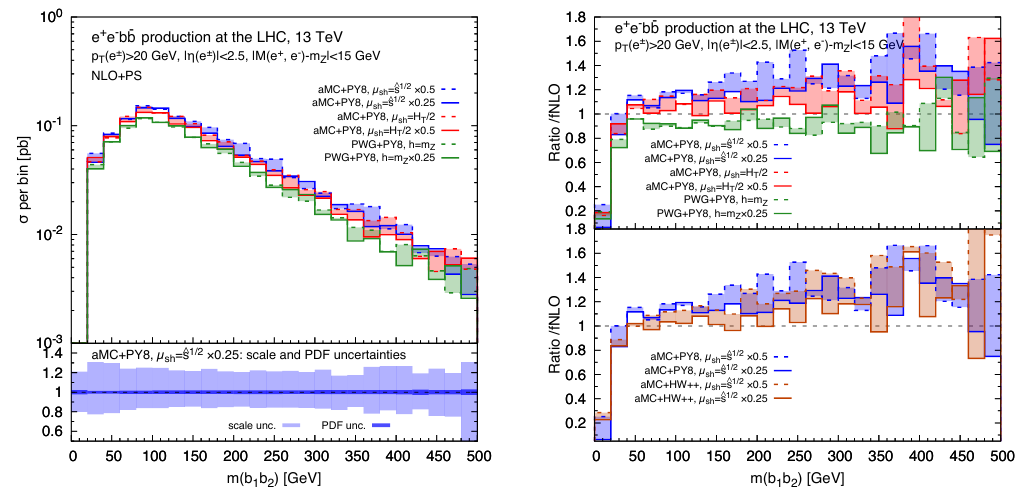
Figure 19 . Invariant mass distribution of the hardest b -jet